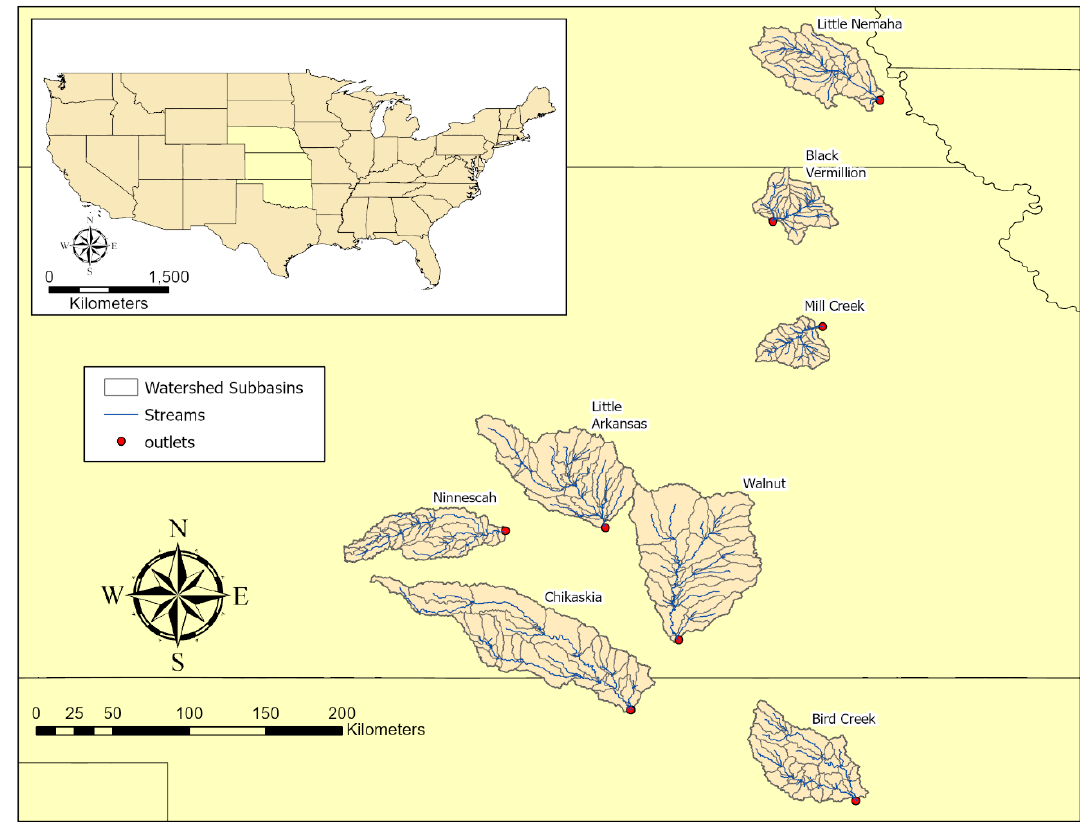
Figure 1. Locality map illustrating the position of the eight examined watersheds.